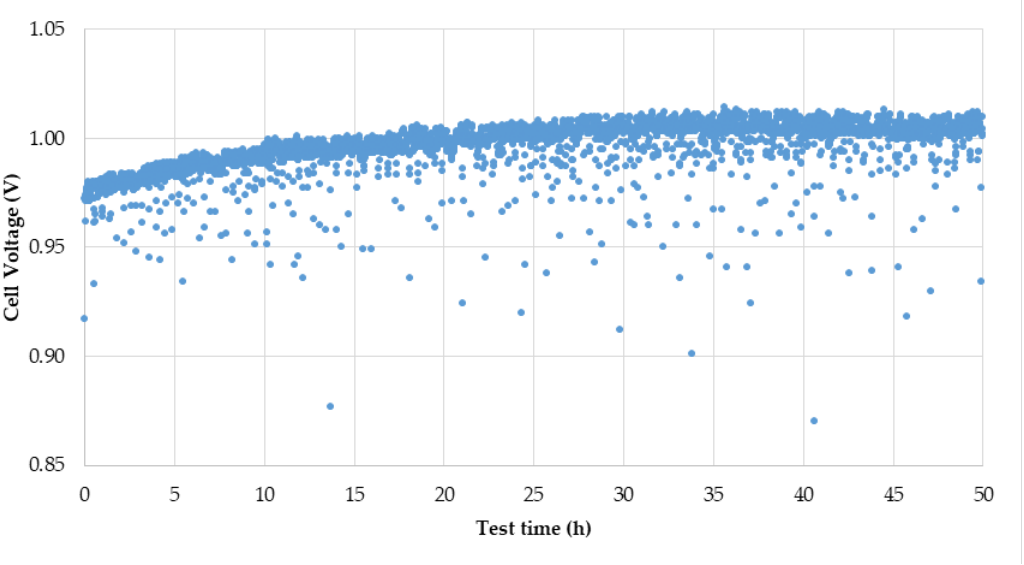
Figure 4. SOE endurance test, 800 ◦ C, 250 mA / cm 2 , 50%–50% H2-H2O.